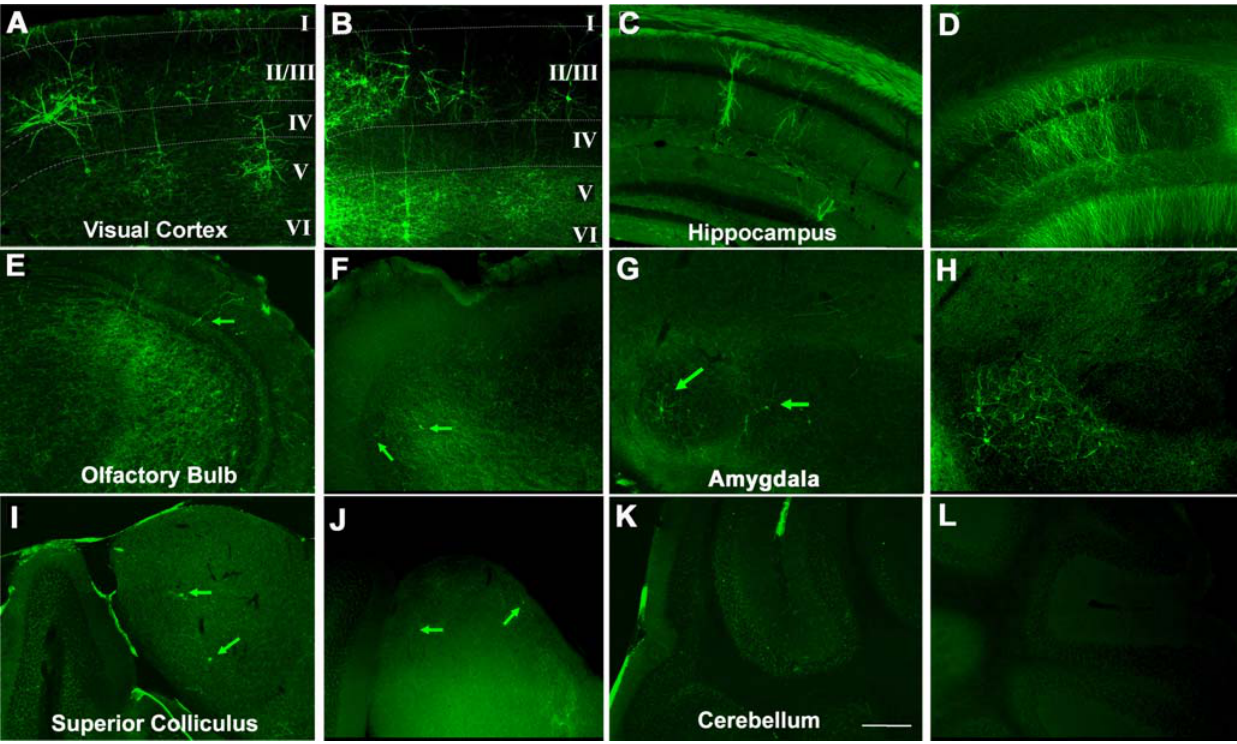
Figure 3. Mosaic transgene expression in various parts of the adult forebrain. Epi-fluorescence microscopy images showing expression of EGFP-F in TLG 498 + Cre 3487 + transgenic mice at 2 months of age in (A) pyramidal cells in layers II/III and V/VI of visual cortex, C) pyramidal and granule cells of hippocampus, (E) granule cells of the olfactory bulb, (G) pyramidal cells of amygdala and (I) piriform cells in superior colliculus (arrows). There is no expression in the cerebellum (K). Scale bar 2 200 m m. A very similar expression pattern was observed in 2 K month old TLG 1157 + Cre 3487 + transgenic mice as shown in the juxtaposed figures (same scale): (B) pyramidal cells in visual cortex, (D) granule cells of hippocampus, (F) granule cells of the olfactory bulb, (H) pyramidal cells of amygdala, and (J) piriform cells in superior colliculus. Again, no expression was observed in cerebellum (L).